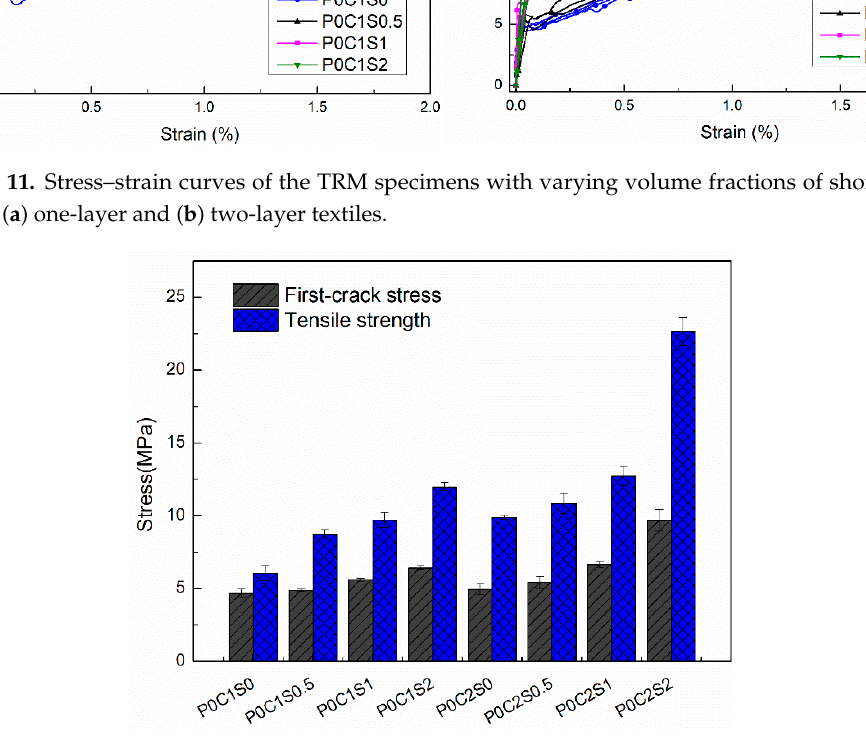
Figure 12. First-crack stress and tensile strength of the TRM Figure 12. First ‐ crack stress and tensile strength of the TRM specimens.